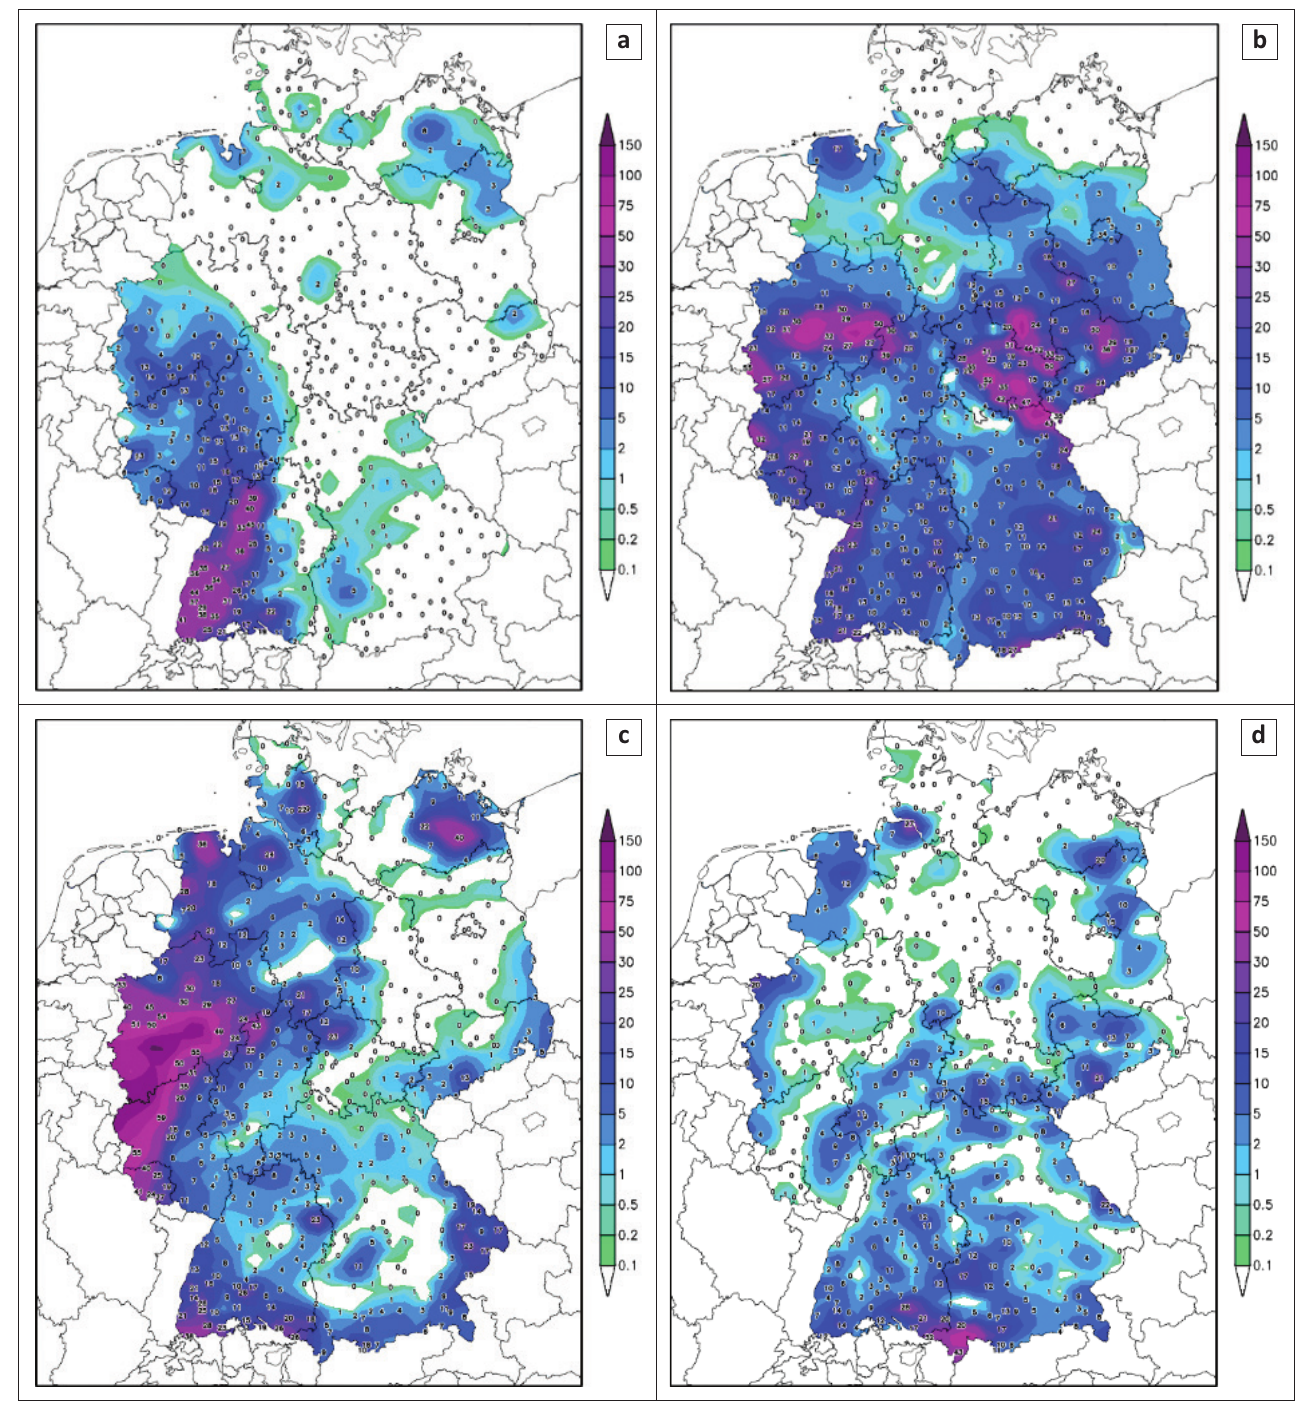
FIGURE 1: Total 24-h precipitation received across Germany: (a) 12 July 2021, (b) 13 July 2021, (c) 14 July 2021, (d) 15 July 2021.